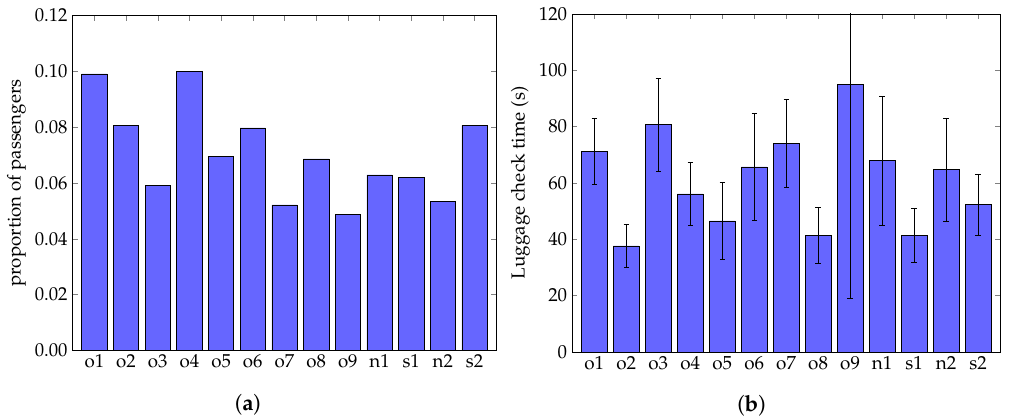
Figure 13. Statistics related to luggage check for the 13 different security checkpoint lanes. ( a ) The proportion of passengers that receive a luggage check. ( b ) The mean luggage check time in a lane, along with the standard